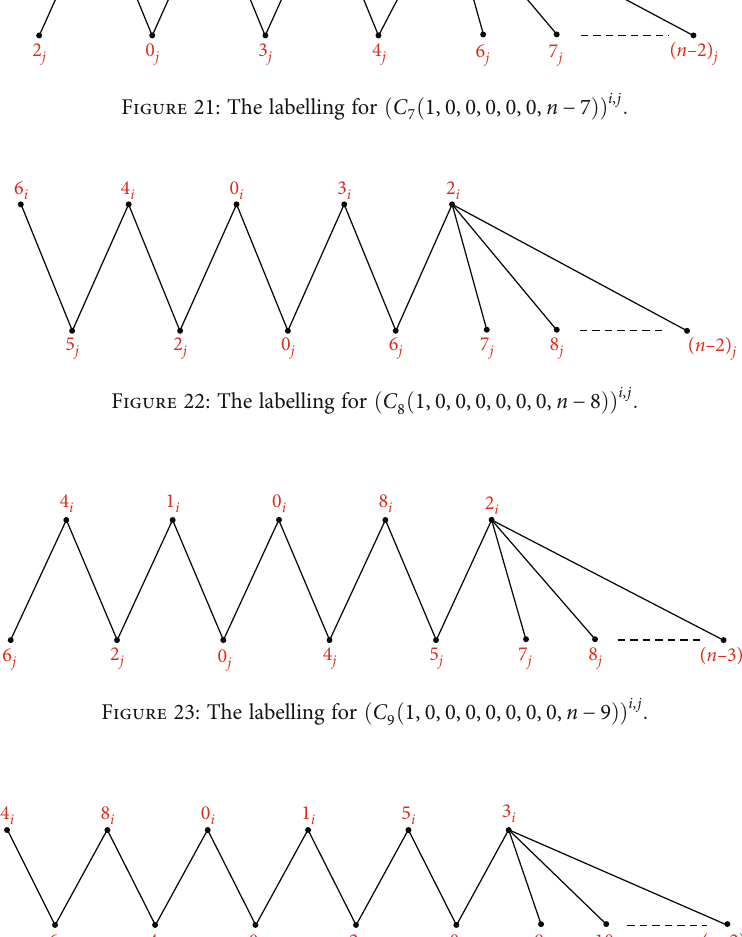
Figure 24: The labelling for ð C